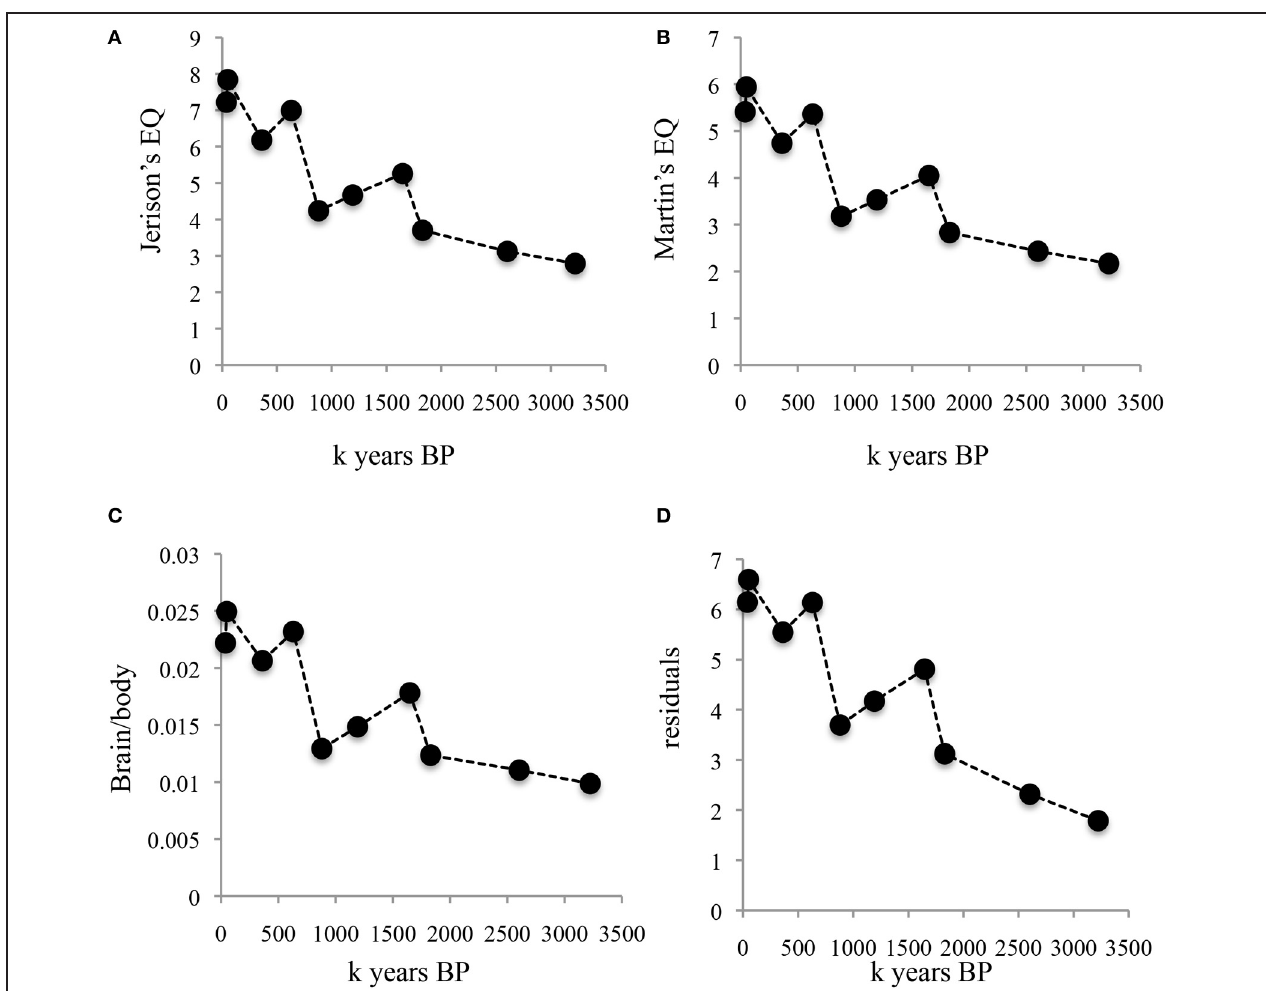
FIGURE 3 | Changes over time in allometrically corrected brain and body size averaged for periods and clades. (A) Brain size corrected for body size according to Jerison’s EQ. (B) Brain size corrected for